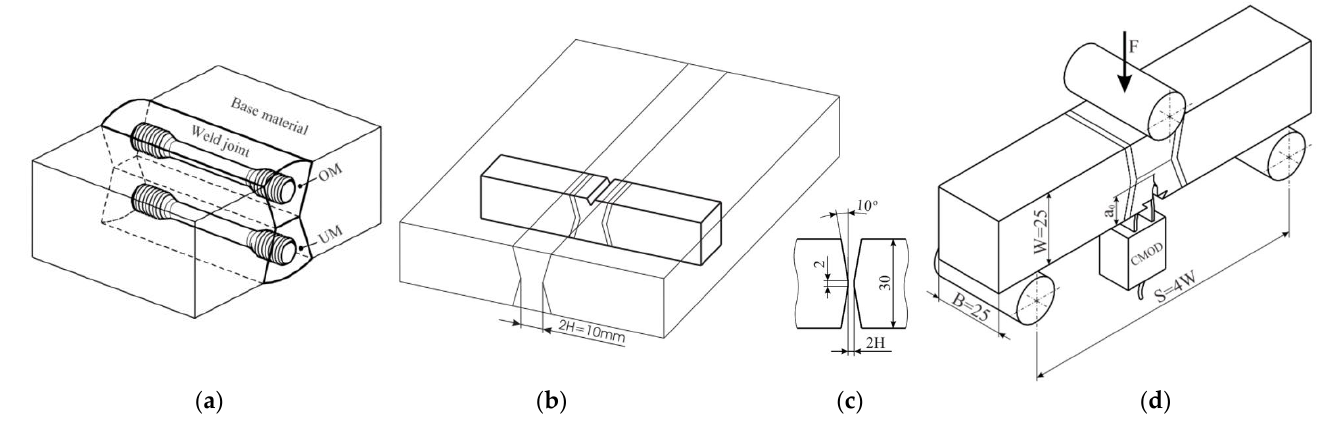
Figure 7. Tensile and fracture toughness specimens: ( a ) position and orientation of tensile specimens; ( b ) fracture toughness specimen notch orientation; ( c ) weld arrangement; ( d ) three point bending specimen SE(B) for fracture toughness testing.